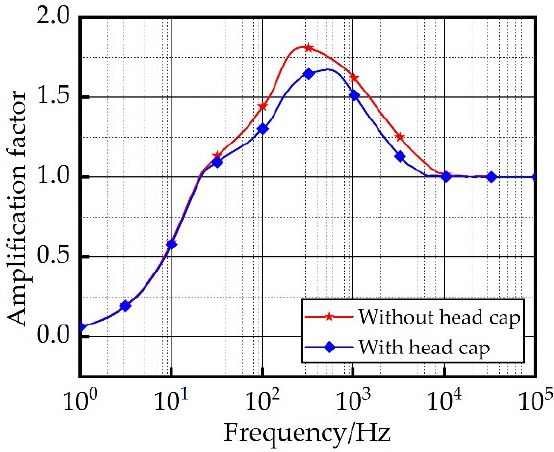
Figure 23. Acceleration shock response spectrum of vehicle vertical water entry at 300